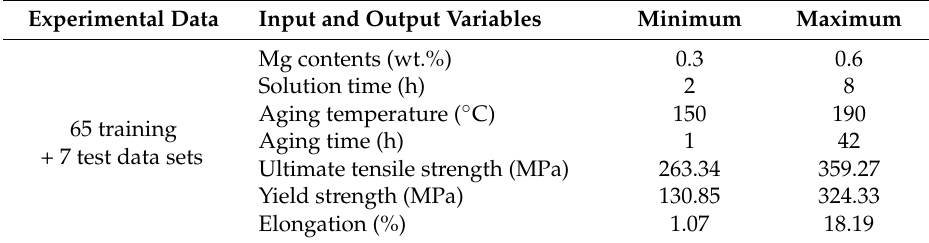
Figure 1. Schematic of tensile test specimens (mm) in the present study. Table 2. Statistics of inputs and outputs used in the present model development.